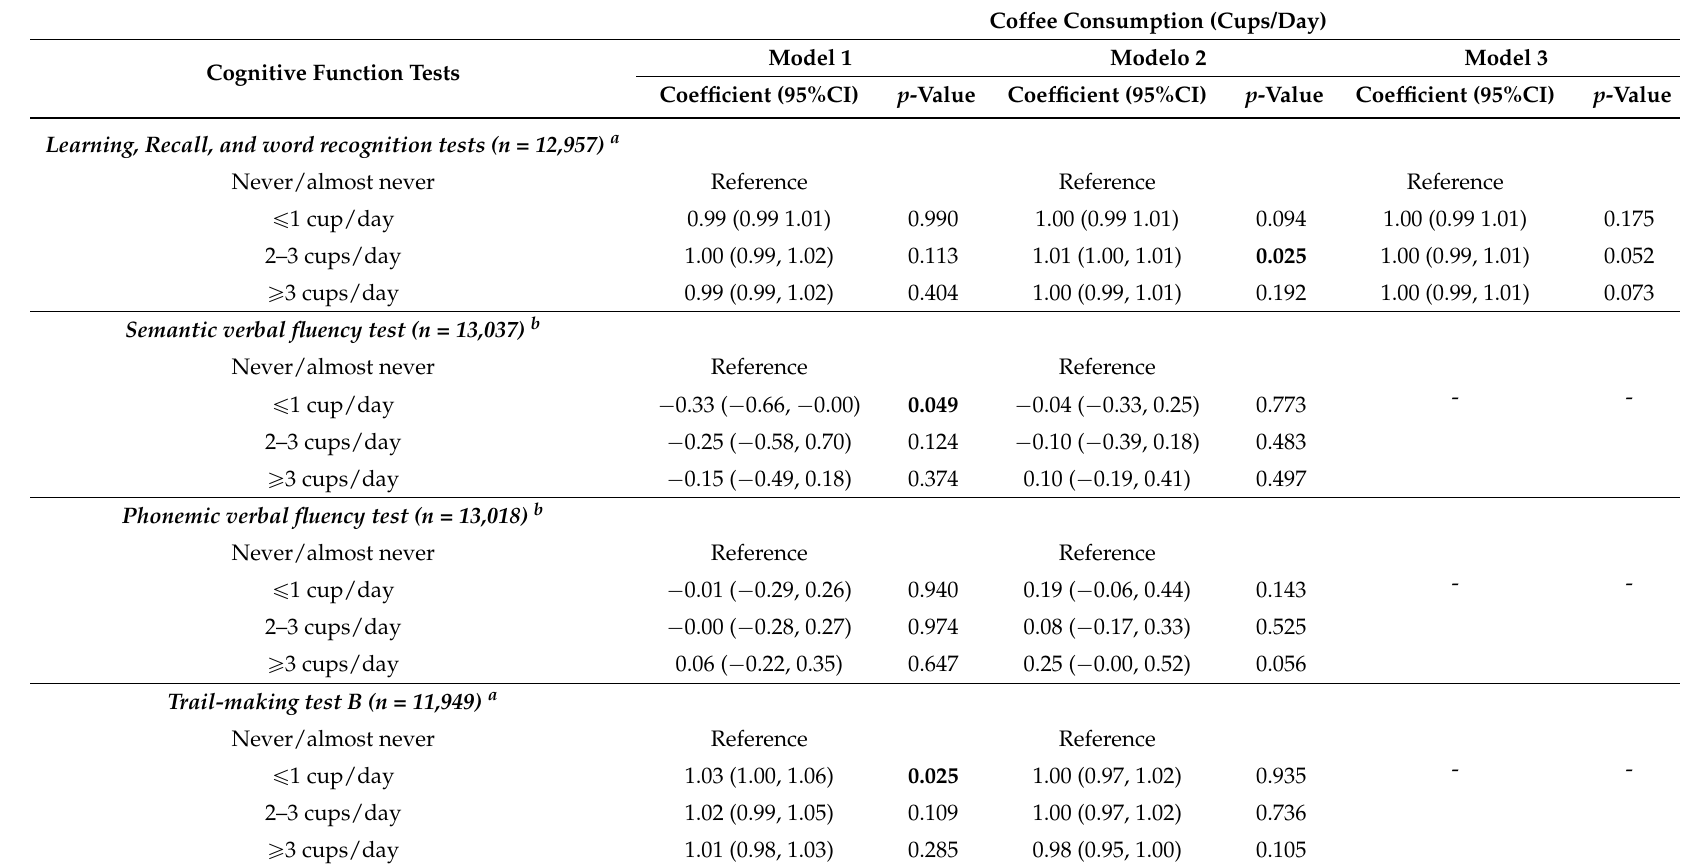
Table 3. Associations between coffee consumption and learning, recall, and word recognition tests, phonemic verbal fluency tests, and trail-making test B among the participants (35 to 64 years of age) of ELSA-Brasil (2008–2010).